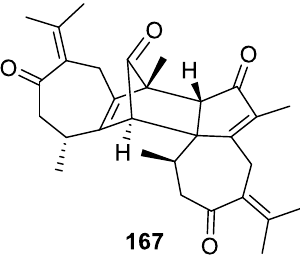
Figure 80. Vieloplain G isolated from Xylopia vielana containing a [5.6.0] spirocyclic scaffold.